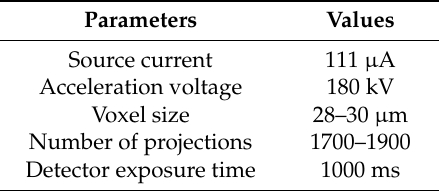
Table 1. Parameter settings for the computed tomography (CT)